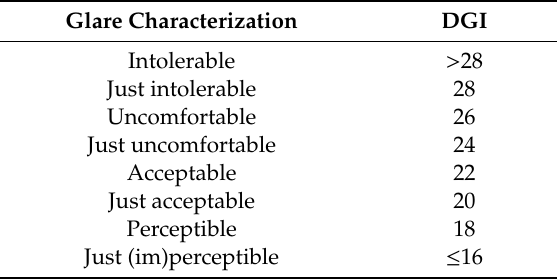
Table 4. Characterization of glare according to the Daylight Glare Index (DGI)